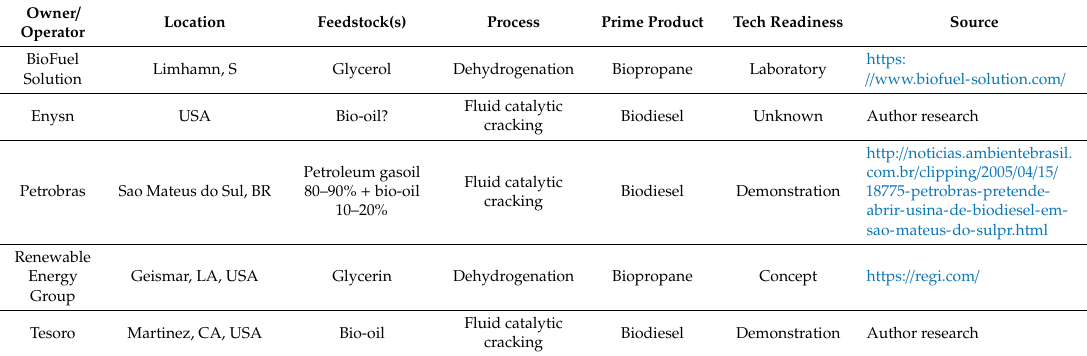
Table 3. Dehydration projects that might produce